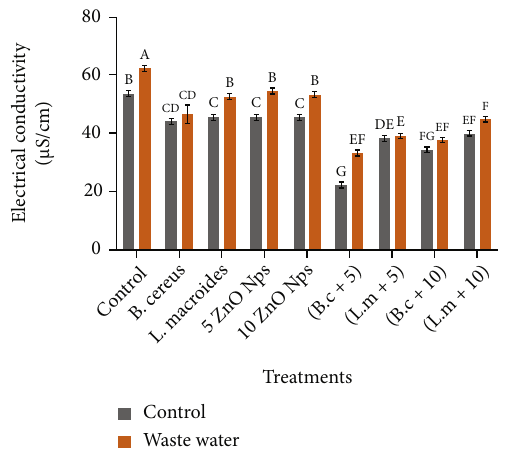
Figure 4: Synergistic e ff ect of bacteria strains ( Bacillus cereus and Lysinibacillus macroides ) and ZnO NP (5 mg/L and 10mg/L) treatments on cellular injury of rice grown in heavy metal- contaminated water. Error bars showed means of standard error ( ± SE) of three replicates ( n = 3 ) followed by di ff erent alphabetic letters showing statistical signi fi cance at 5% probability